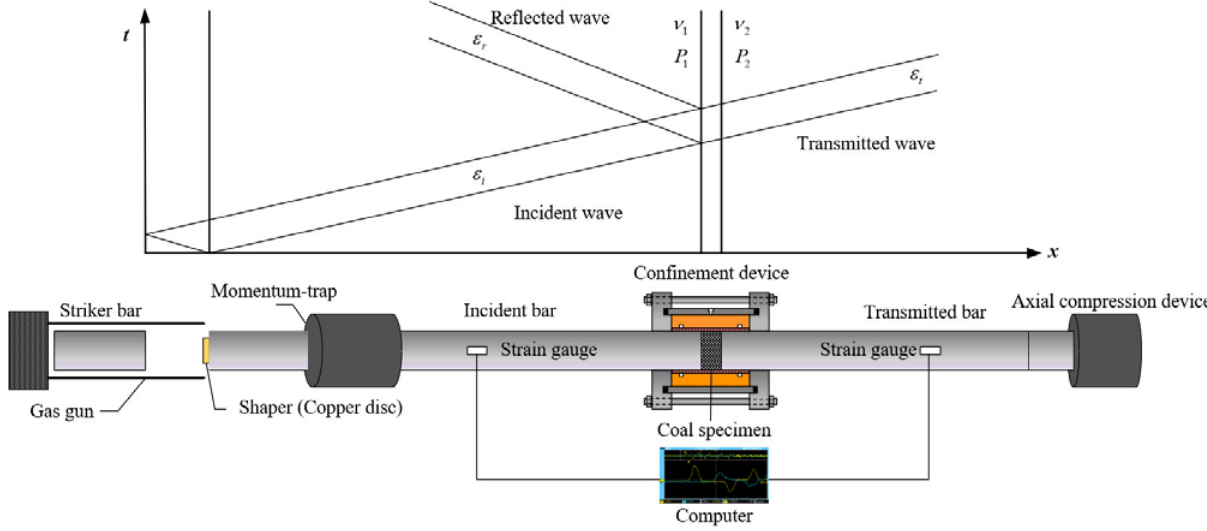
Figure 3. Schematic diagram of the active triaxial SHPB test system.